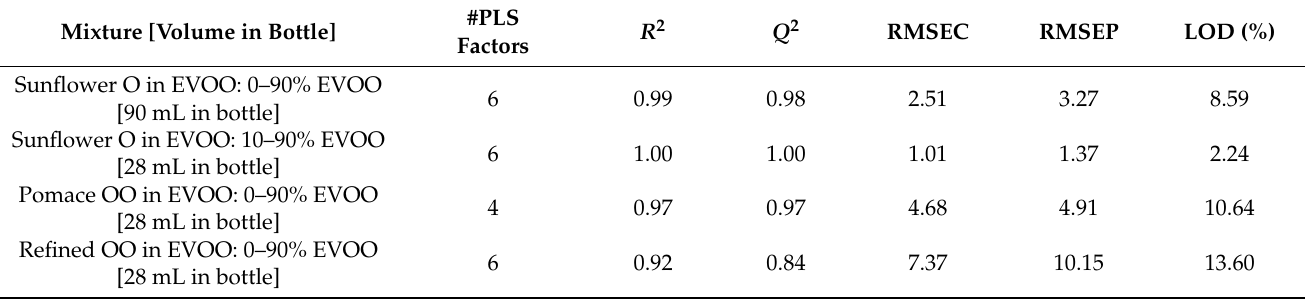
Table 2. PLSR results for the bootstrap models of the adulterated oils in EVOO using SORS for through-container analysis. #PLS Mixture [Volume in Bottle] R 2 Q 2 RMSEC RMSEP LOD Factors